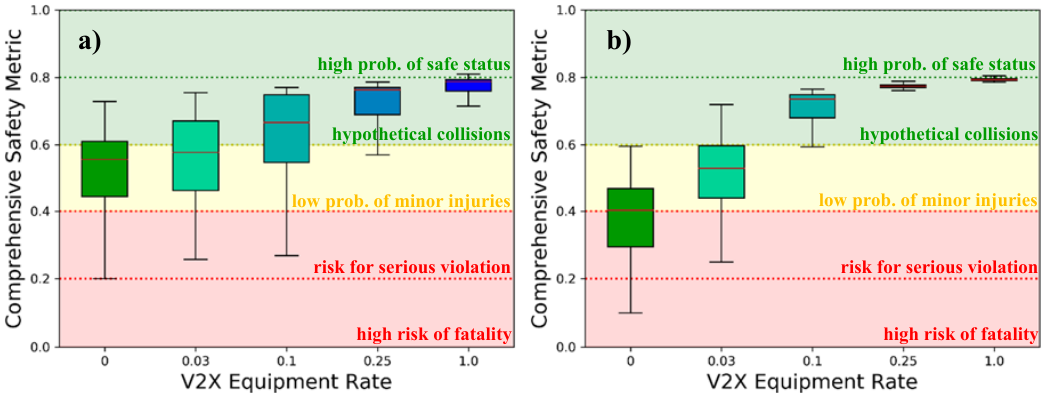
Figure 15. Comprehensive Safety Metric for ( a ) the low-density scenario and ( b ) the high-density scenario with the corresponding safety levels as stated in [44].